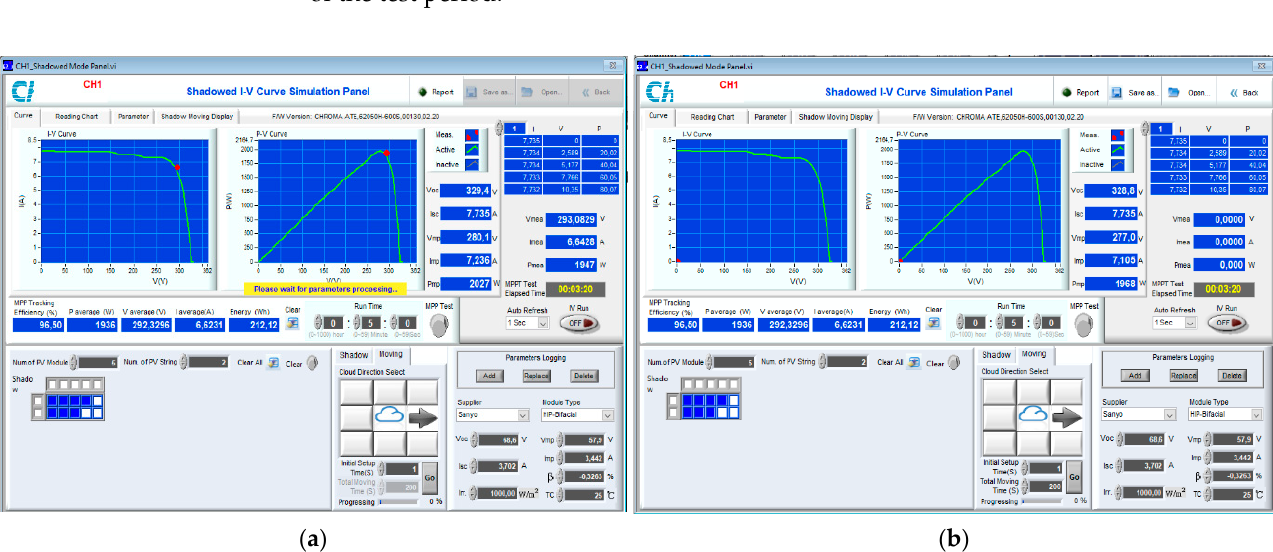
( b ) Figure 15. EKF MPPT test of two − phase IBC with 3 kW load: ( a ) partial shading and global MPPT tracking; ( b ) overall MPPT tracking efficiency. The measured power and efficiency rates are obtained from Chroma SAS’s precise measuring tool, which tracks the source power drawn from the solar plant and the load power delivered at the output of the solar converter. As a result, instant variations and overall efficiency values are precisely calculated in this manner. The partial shading tests of the proposed EKF MPPT confirmed that the two − phase IBC could provide tracking efficiency of more than 96% at any load value up to 3 kW. In contrast, the power conversion efficiency of IBC was found to be 99.93% based on meas- urements obtained during the experimental analysis of the Chroma solar array simulator.